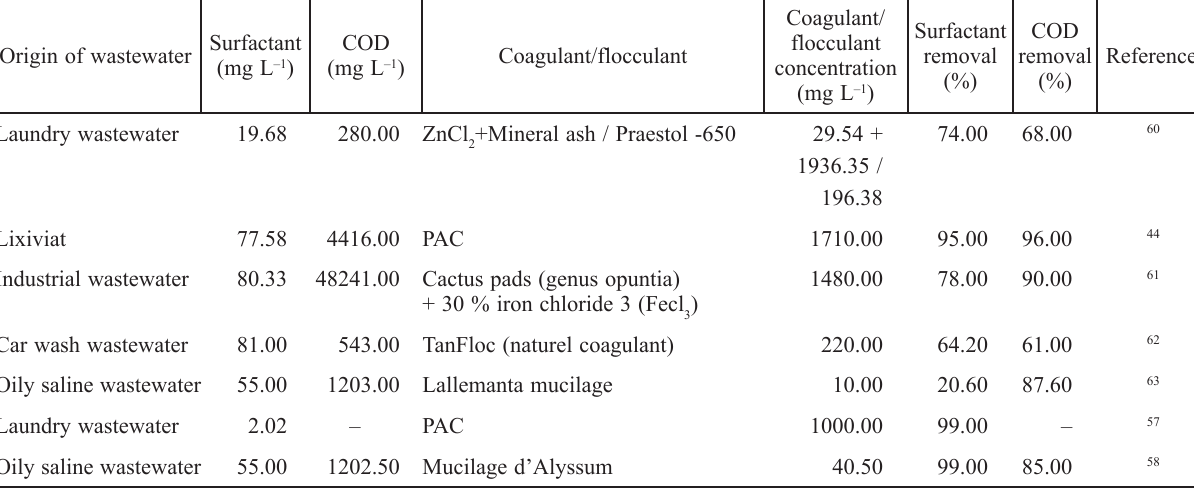
Table 4 – Removal of COD and surfactants from wastewater by a coagulation-flocculation process Surfactant Origin of wastewater (mg L –1